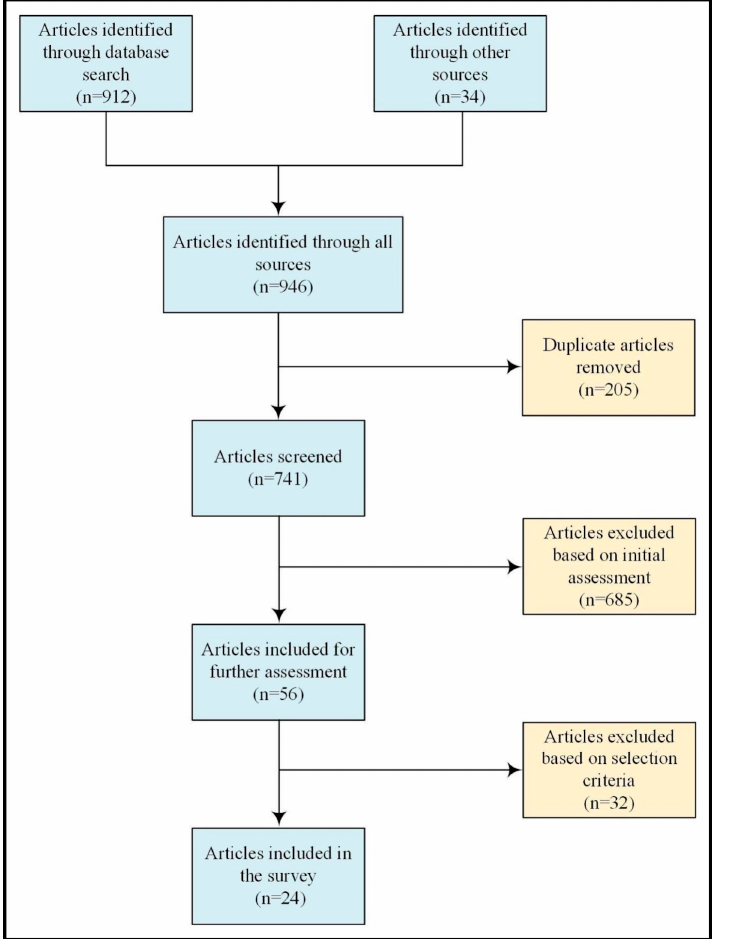
Figure 3. Search results and how we selected the 24 articles that described 19 IVTs.